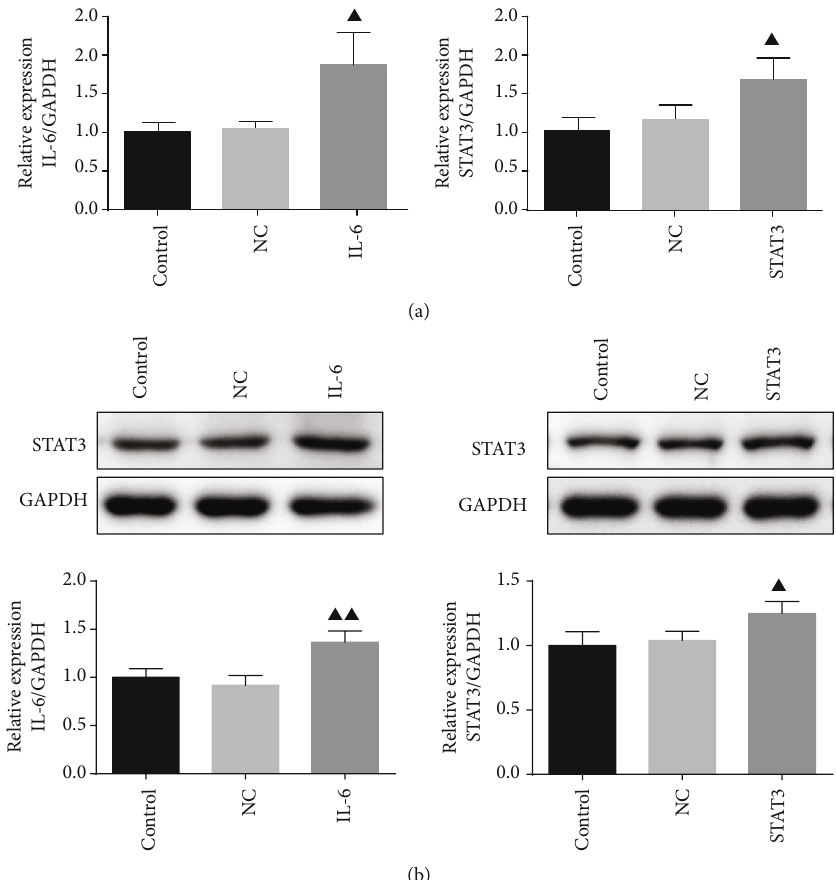
Figure 8: Validation of IL-6 and STAT3 levels in transfected IEC-6 cells. IEC-6 cells were transfected with STAT3 overexpressed plasmid and IL-6 overexpressed plasmid, respectively; the expression of IL-6 and STAT3 in transfected IEC-6 cells was validated by qRT-PCR analysis (a) and western blot assay (b). Data were expressed as mean ± standarderror mean (SEM), ▲ p value < 0.05 vs. control